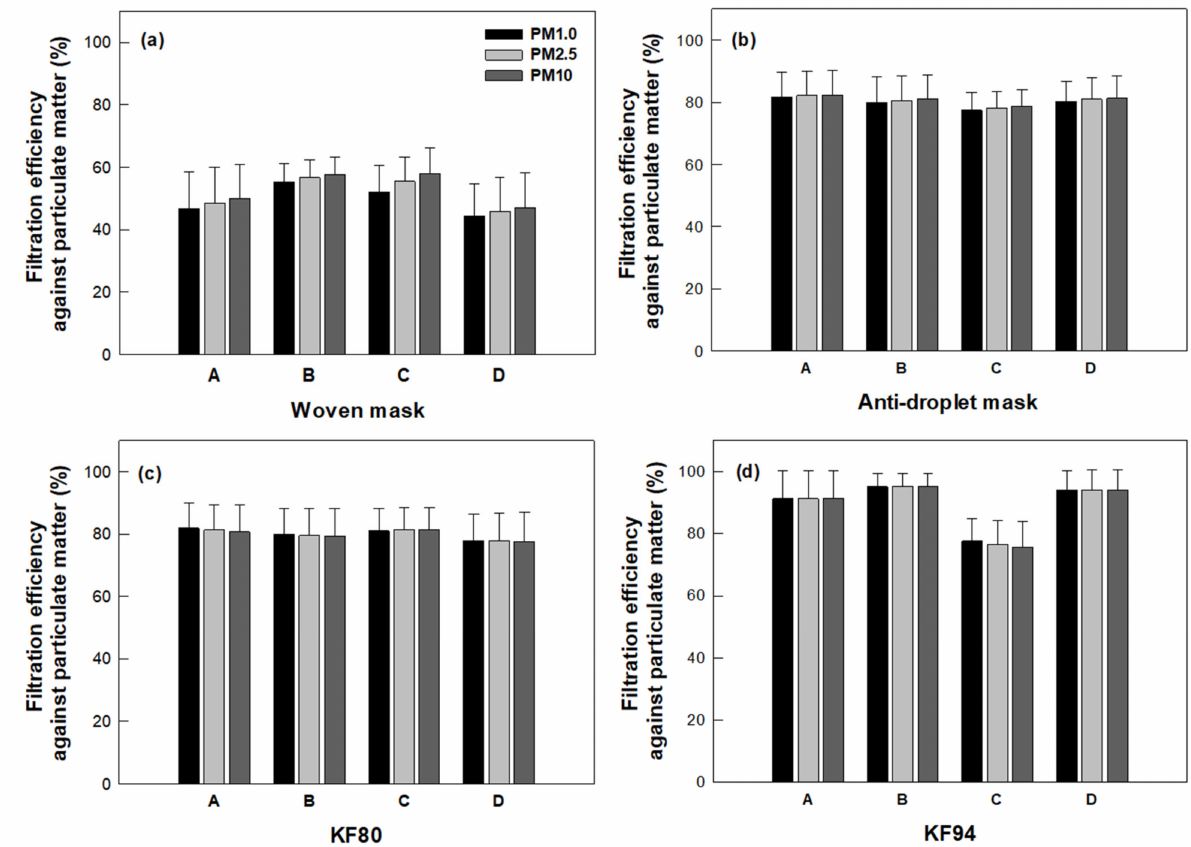
Figure 2. Efficiency levels of commercially available face masks at filtering air particulate matters (PMs) ( n = 3). ( a ) Woven, ( b ) antidroplet, ( c ) KF80, and ( d ) KF94 masks. A, B, C, and D indicate categories of the masks described in Table